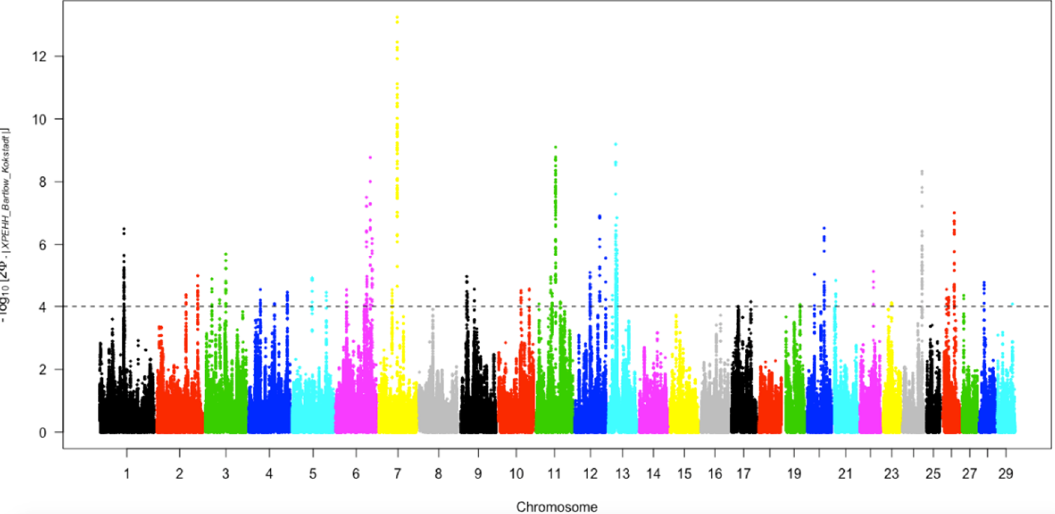
Figure 9. Genome−wide distribution of selection signatures detected by XPEHH across all auto- Figure 9. Genome − wide distribution of selection signatures detected by XPEHH across all autosomes somes in Bartlow Combine and Kokstad Nguni cattle populations. in Bartlow Combine and Kokstad Nguni cattle